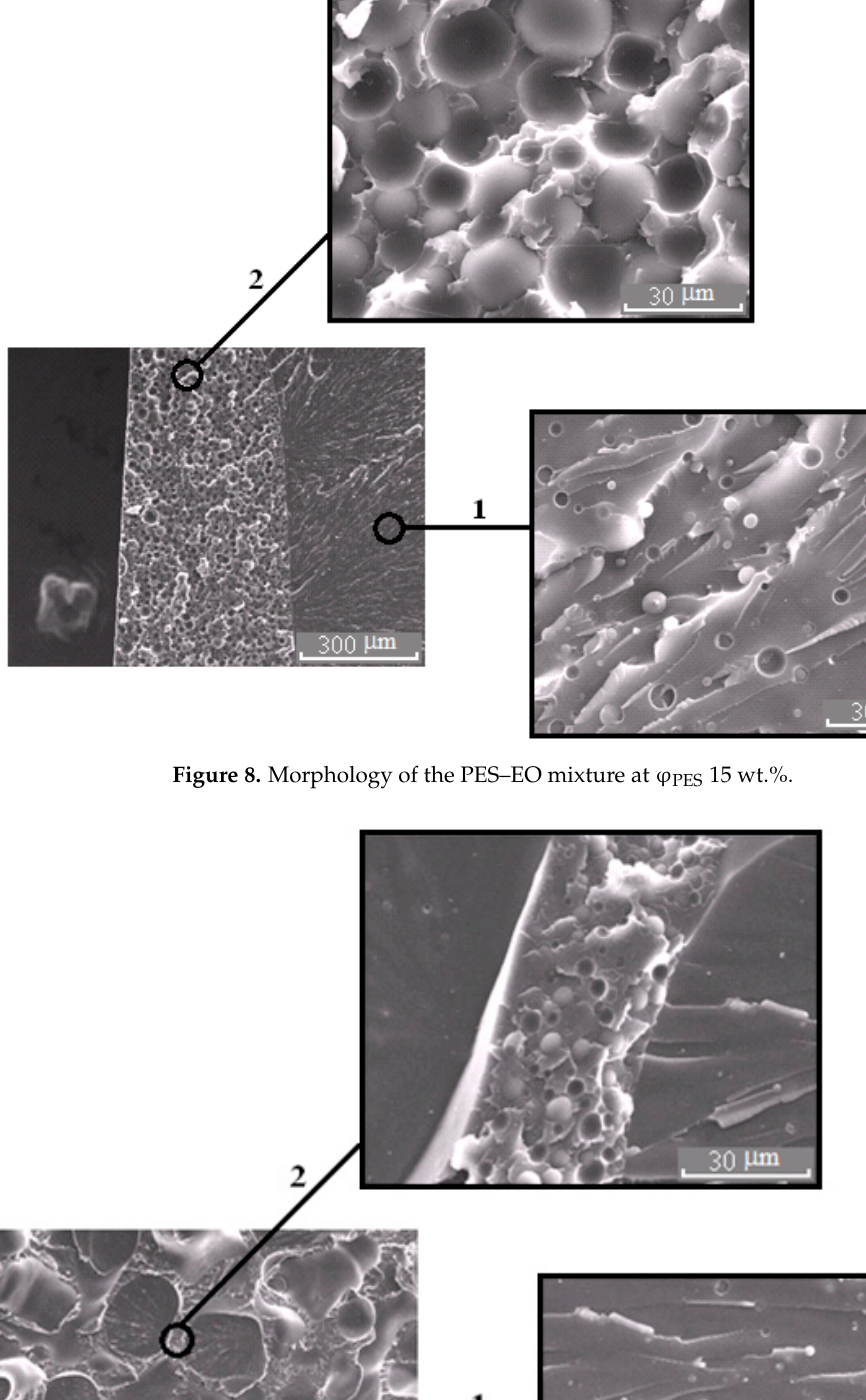
Figure 9. Morphology of the PES–EO mixture at φ PES 20 wt.%.